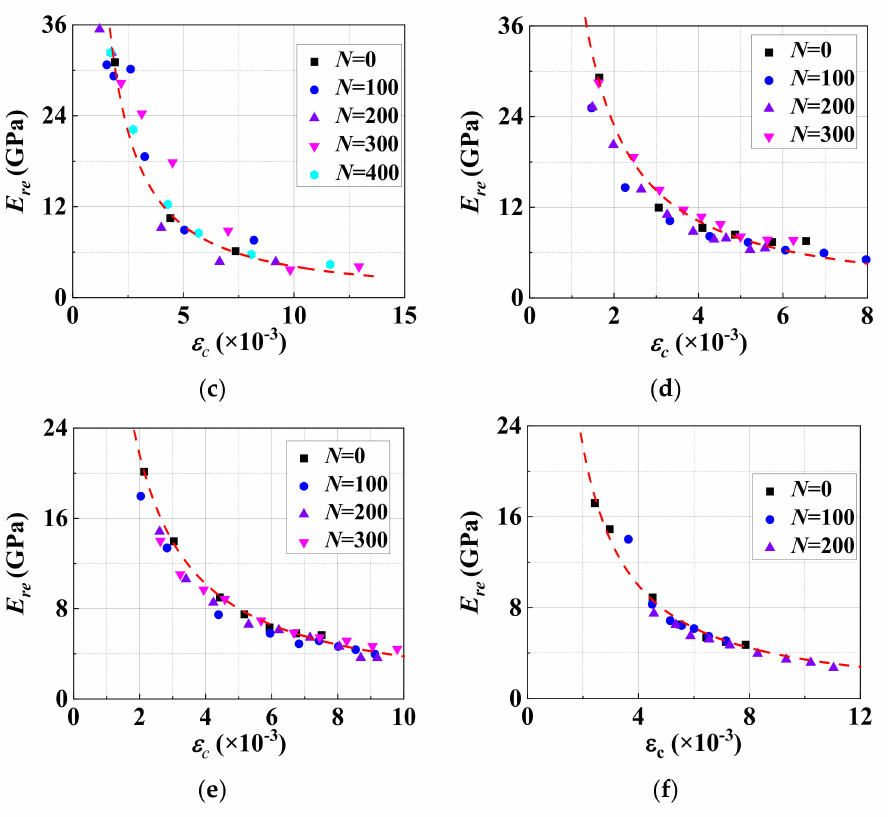
Figure 9. Relationship between reloading modulus and strain after peak point